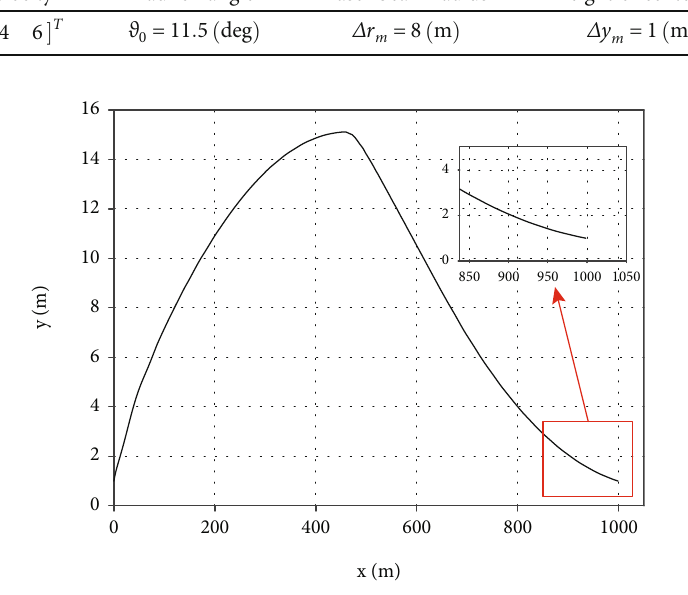
Figure 4: Flight trajectory.